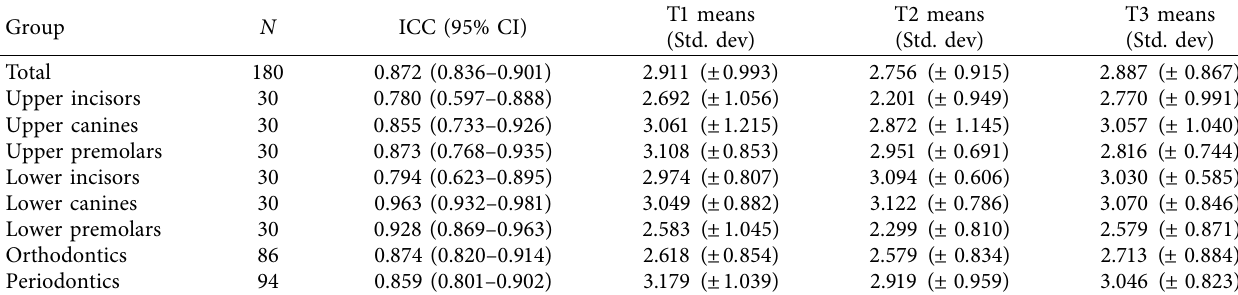
Table 5: Interrater ABC-CEJ by tooth groups and clinic